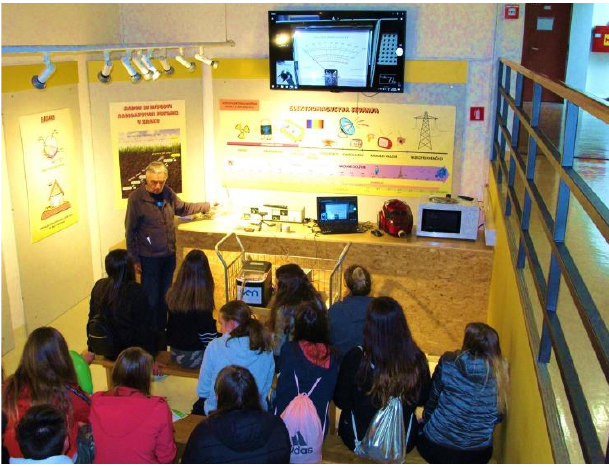
Fig. 6. Radioactivity workshop in Nuclear Technology Information Centre.